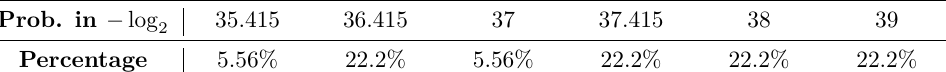
Table 5: Predicted probability distribution across all valid keys for the differential characteristic in Table 4.